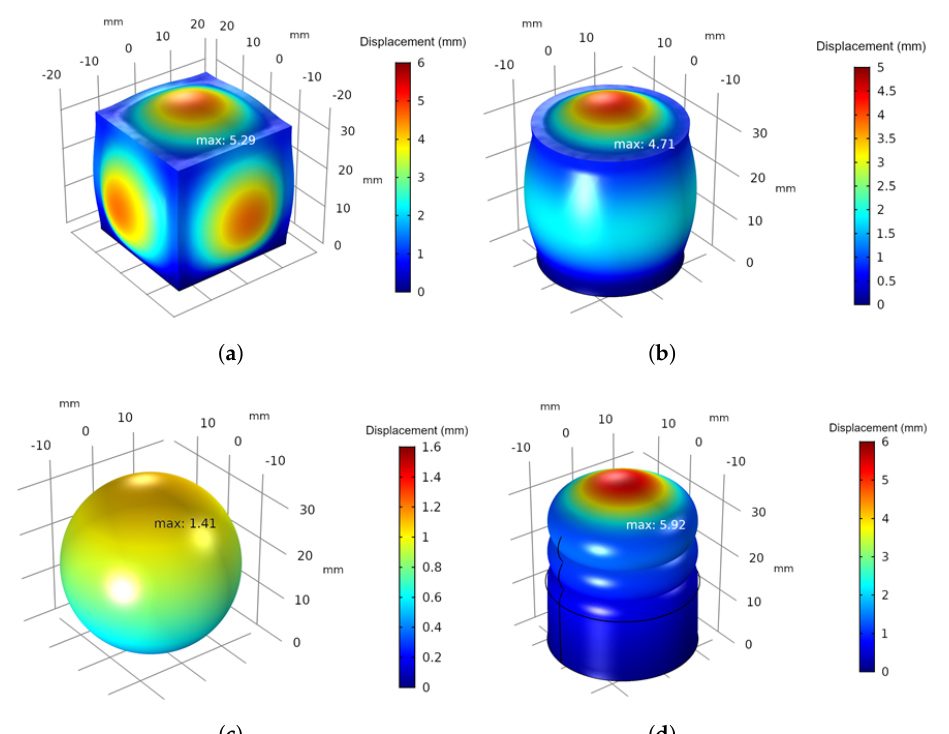
Figure 1. An example of the inflation behavior of 30 mm geometries with 3 mm walls under an internal pressure of 50 kPa. ( a ) Cubic geometry. ( b ) Cylindrical geometry. ( c ) Spherical geometry. ( d ) Bellows-based geometry. As can be observed in ( a ) and ( b ), part of the air flow is wasted on the expansion of the walls to different degrees depending on the geometries, which does not contribute to the forward displacement. This method does not seriously affect sphere-based geometry, but due to manufacturing criteria, bellows-based geometry is an important option to